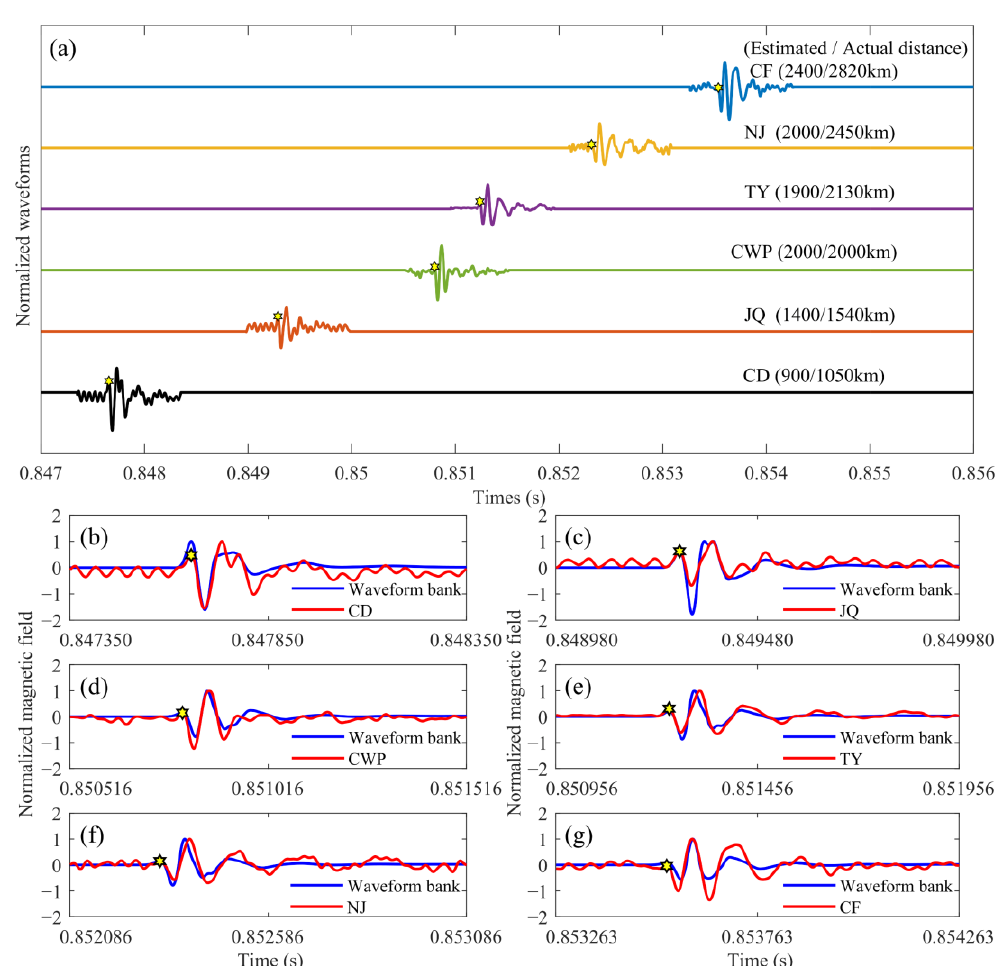
Figure 2. ( a ) Normalized waveforms for a lightning source outside the network at 16:48:13 on 3 October 2021, Beijing time. The minimum distance between the source and sensors is greater than 1000 km. The ground wave peak points are marked by yellow hexagrams, and the estimated distance (left) and the actual distance (right) are marked between parentheses. ( b – g ) The recognition result of the ground wave peak point for each measured waveform by the matched waveform bank.